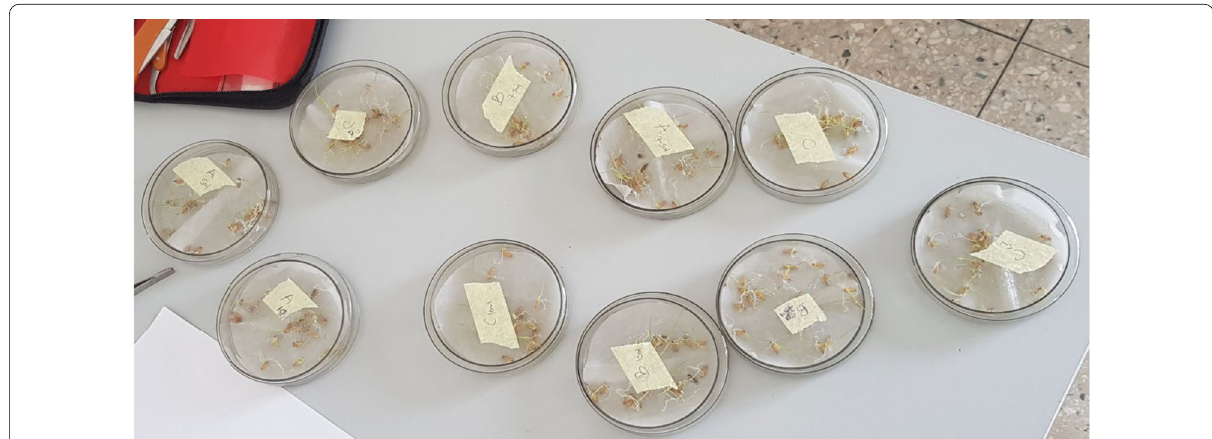
Fig. 10 Showing In vitro germination of rice after inoculation with the three PSBs at 2DAS. DAS C Klebsiella sp ., D = =